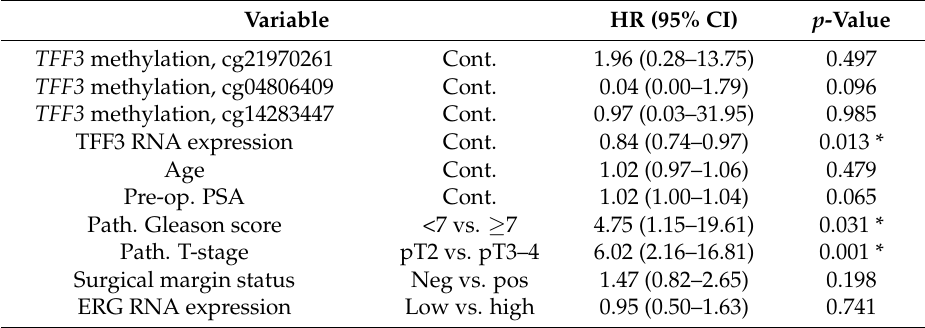
Table 4. Cox regression analysis of PSA recurrence-free survival after radical prostatectomy in the TCGA PC patient cohort ( n = 389). TFF3 methylation for CpG site No. 4. Abbreviations: